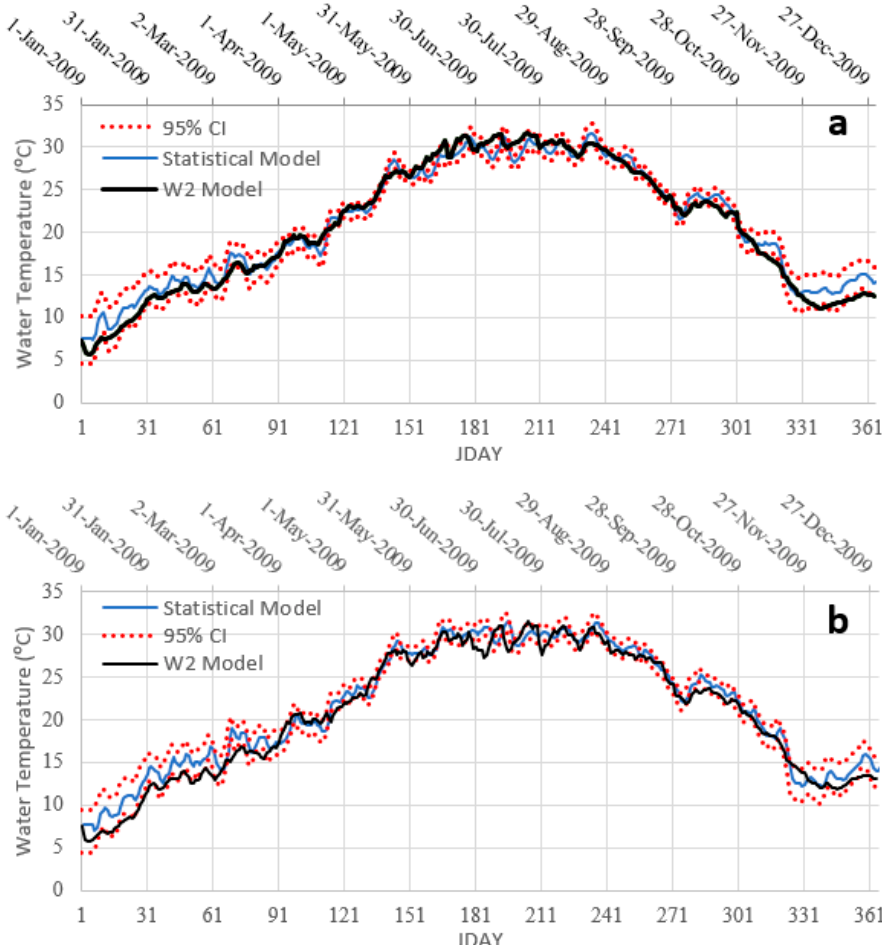
Figure 6. W2 model predictions of T w compared with a statistical model of T w at ( a ) Baeji and ( b ) Baghdad.